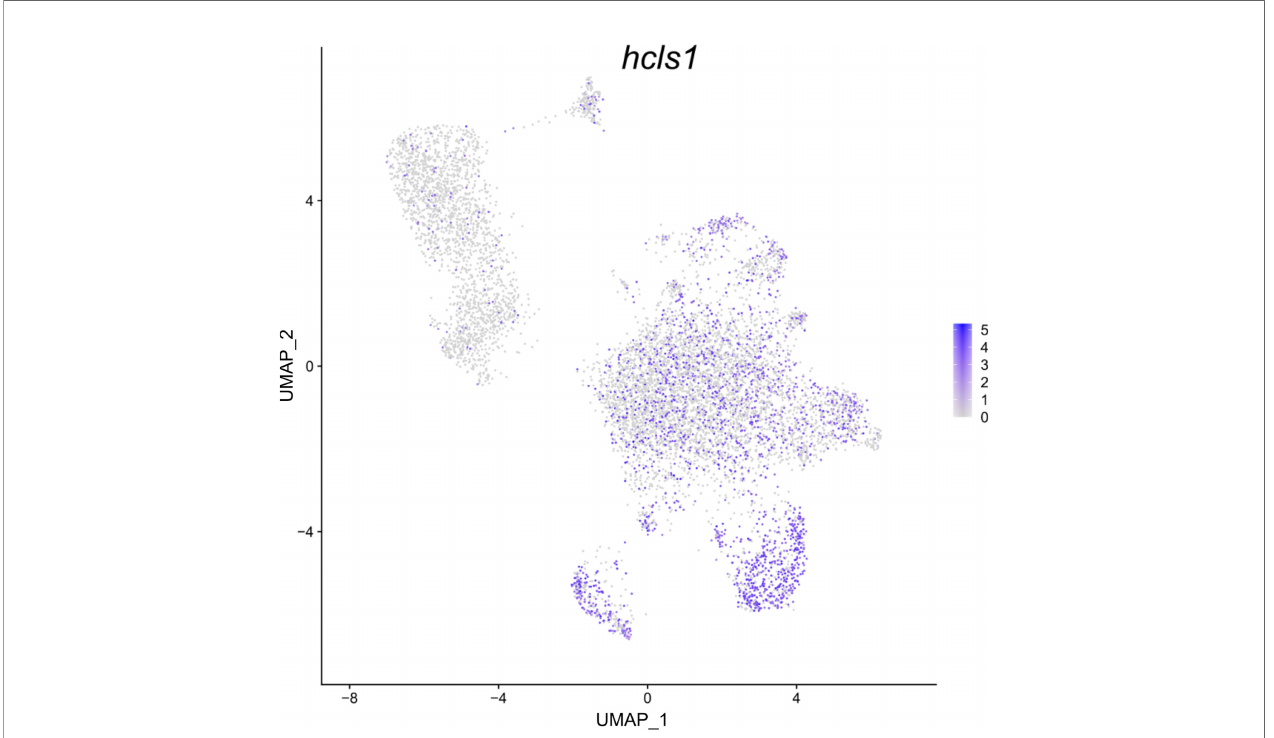
FIGURE 4 | Feature plot highlighting Syngnathus typhle blood and head kidney cells expressing the hcls1 gene within a Uniform manifold approximation projection (UMAP). Increased cell color intensity indicates increased gene